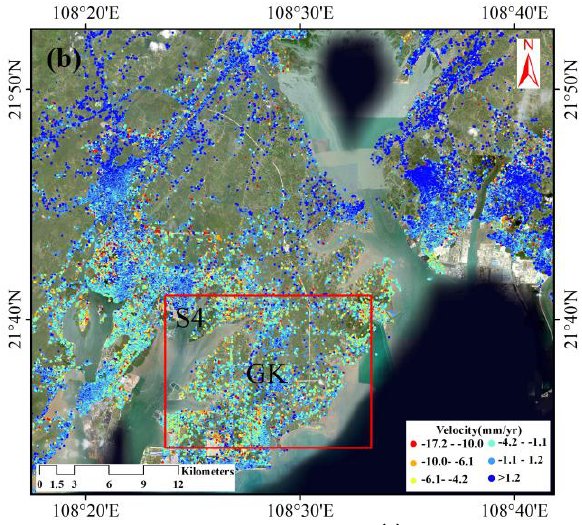
Figure 6. Feature area distribution map: (a) Three Subsidence Characteristic Areas in Beihai Area; and (b) a characteristic area of subsidence in Fangchenggang area A characteristic area of subsidence in Fangchenggang area.